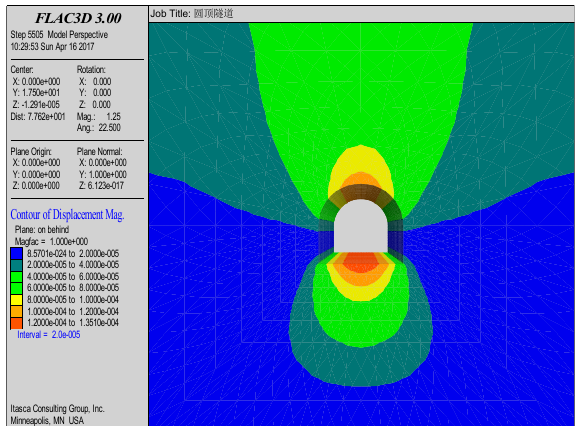
Figure 4. Displacement distributions in surrounding rock after crosscuts excavation. Energies 2019 , 12 , x FOR PEER REVIEW